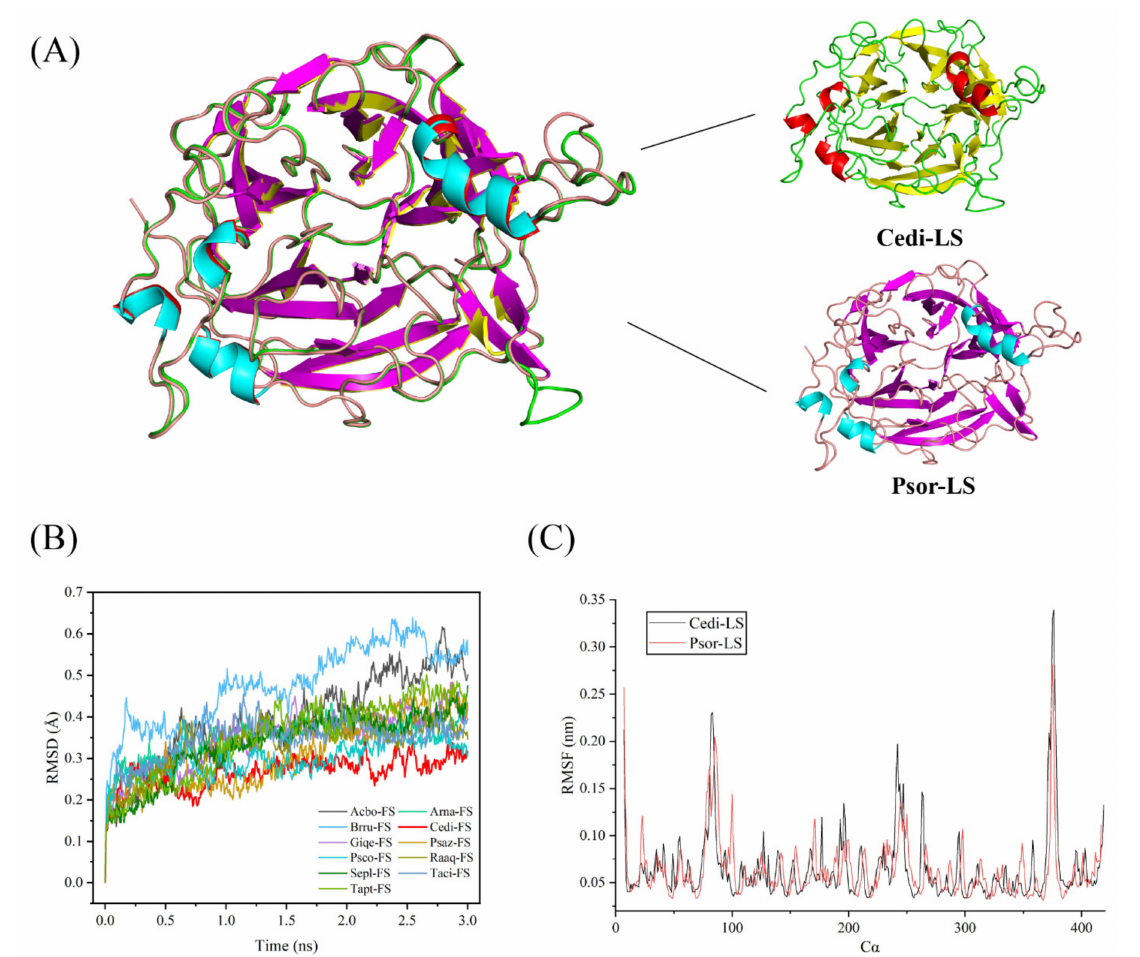
Figure 1. The structure and molecular dynamic simulation of Cedi-LS and Psor-LS. ( A ) The structure comparison of Cedi-LS and Psor-LS. The structures of Cedi-LS and Psor-LS are shown as carton. The superposition structure of Cedi-LS and Psor-LS are made by Pymol. ( B ) RMSD simulations of different microbial FSs at 500 K. ( C ) RMSF of the backbone C α of modeled Cedi-LS and Psor-LS from the molecular dynamic simulation at 280